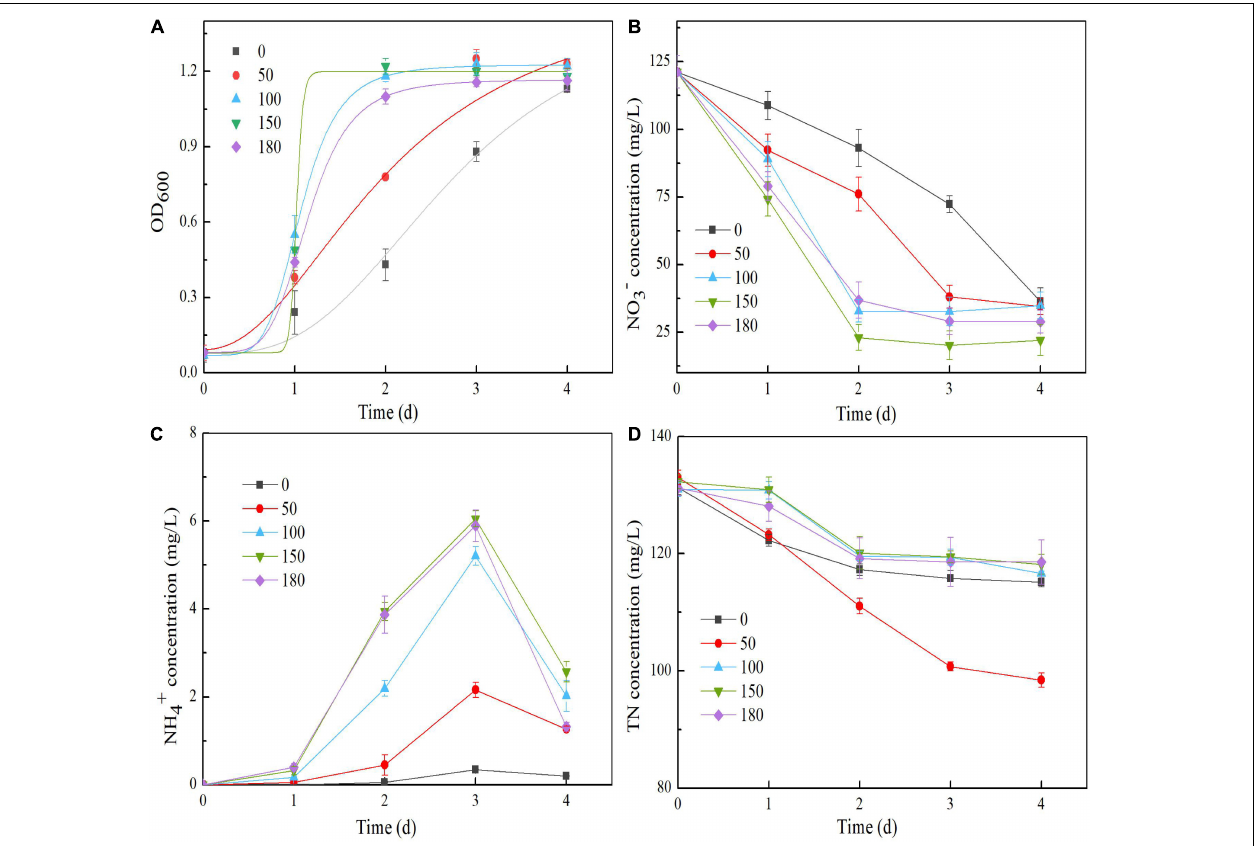
FIGURE 7 | Effects of shaking speed on the OD 600 (A) , NO 3 − concentration (B) , NH 4 + concentration (C) , and TN concentration (D) in the Pseudomonas putida Y-9 culture with glucose as the sole carbon source.